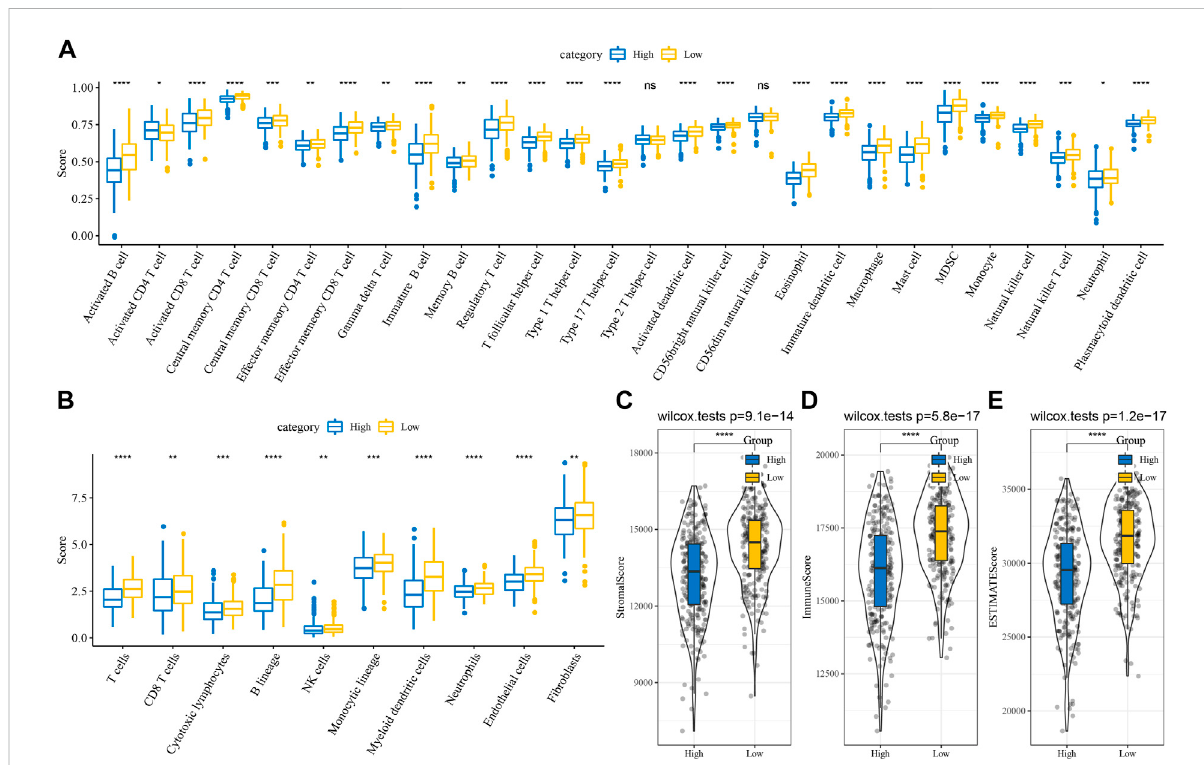
FIGURE 6 Differences of immune in fi ltration in different RiskScore groups (A) Subtype comparison of ssGSEA assessment of 28 immune cell scores; (B) Subtype comparison ofMCP-Counter assessmentof 10immunecell scores; (C) Subtypecomparisonof ESTIMATE assessment ofStromalScore;